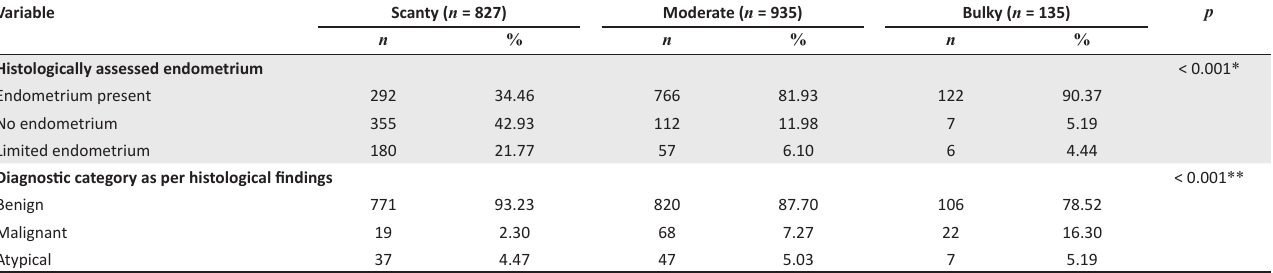
TABLE 2: Macroscopic quantities of endometrial tissue samples received at Chris Hani Baragwanath Academic Hospital Histopathology Laboratory from 01 July 2013 to 31 May 2017 in relation to microscopically assessed endometrial tissue and diagnostic